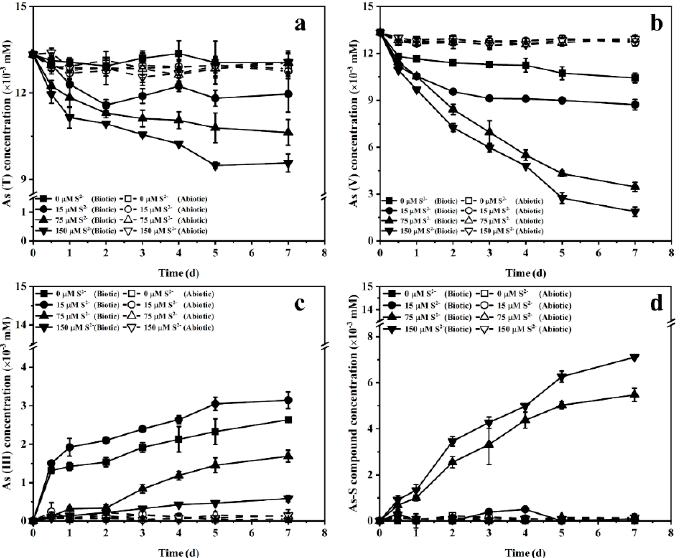
Figure 4. The concentrations of As(T) ( a ), As(V) ( b ), As(III) ( c ) and As–S ( d ) in the medium with or without strain JH012-1 under different initial sulfide